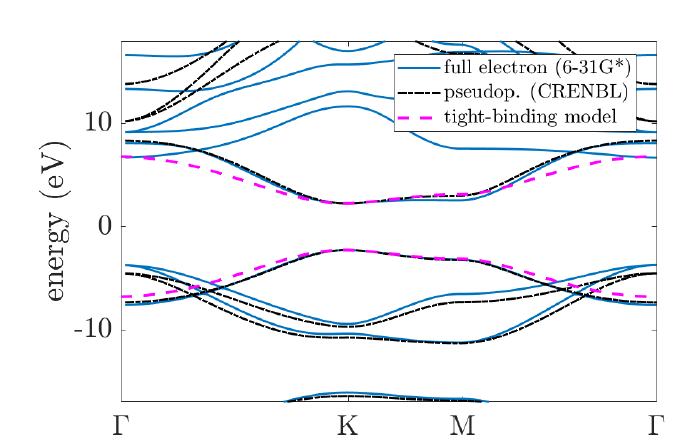
Figure 1: Comparison of the band structure of monolayer hBN using different ap- proaches: (i) a first-neighbour tight-binding two-band model with 2.15 eV hopping, (ii) a DFT calculation using a small-core pseudopotential basis set and (iii) a DFT all-electron calculation (see text for further